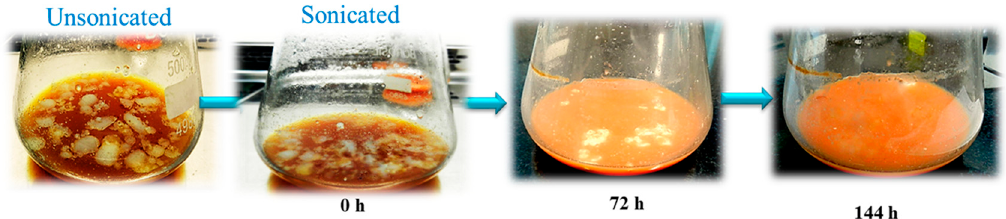
Figure 3. Appearance of fat from ultrasonicated clarified butter sediment waste medium (CBM) during utilization by R. kratochvilovae over a cultivation period of 144 h.